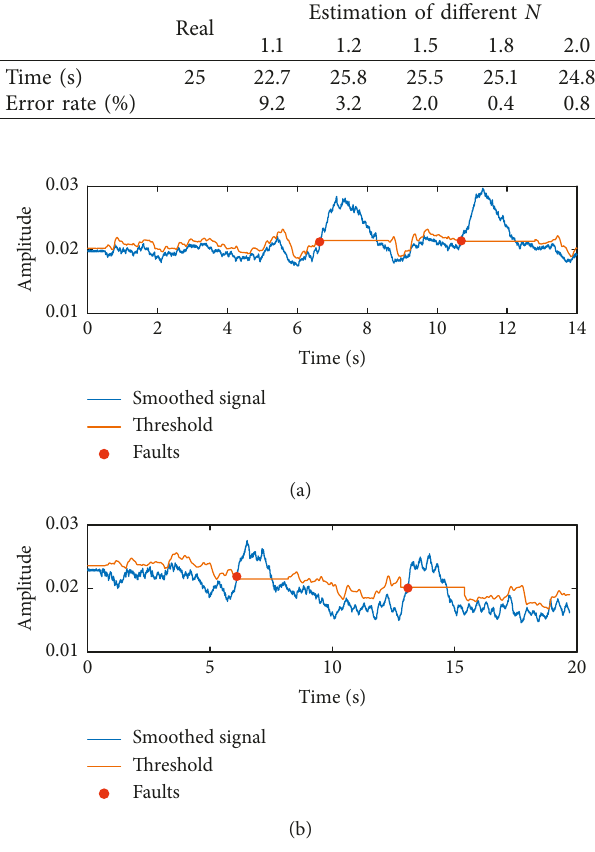
Figure 8: Results of the fault detection: (a) experiment 1 and (b) experiment 2.